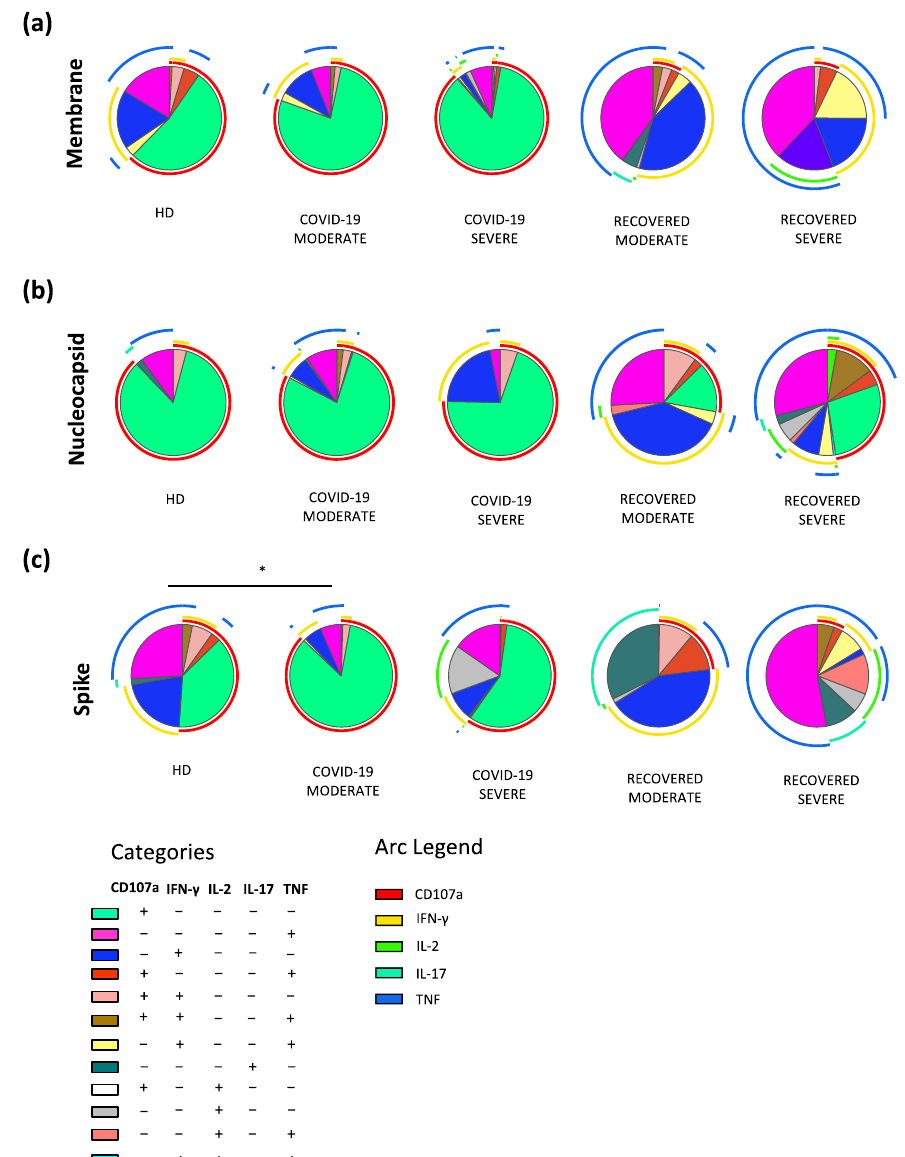
Figure 4. Polyfunctionality of CD8+ T cells after in vitro stimulation. Pie charts representing the proportion of CD8+ T cells producing different combinations of IFN- γ , TNF, IL-2, IL-17, GRZB as well as expressing CD107a after stimulation with ( a ) M; ( b ) N; or ( c ) S peptide pools from HD ( n = 10), COVID-19 moderate ( n = 7), COVID-19 severe ( n = 6), recovered moderate ( n = 9) and recovered severe ( n = 6) patients. Data in pie charts are represented as median values. Frequencies were corrected by background subtraction as determined in non-stimulated controls using SPICE software. Statistical analysis between pie charts was performed using permutation test (* p < 0.05). Pie arches represent the total production of different cytokines.